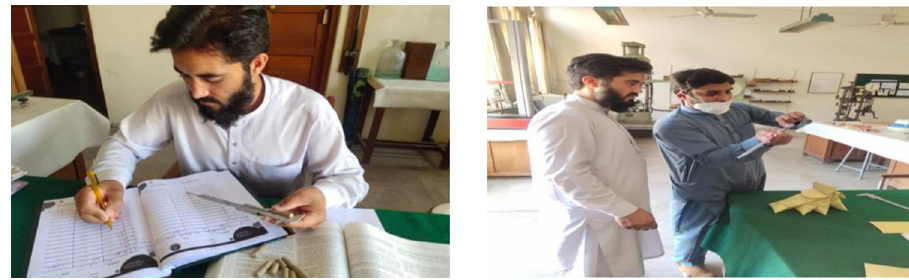
Fig 4. Measuring of length and diameter of biomass